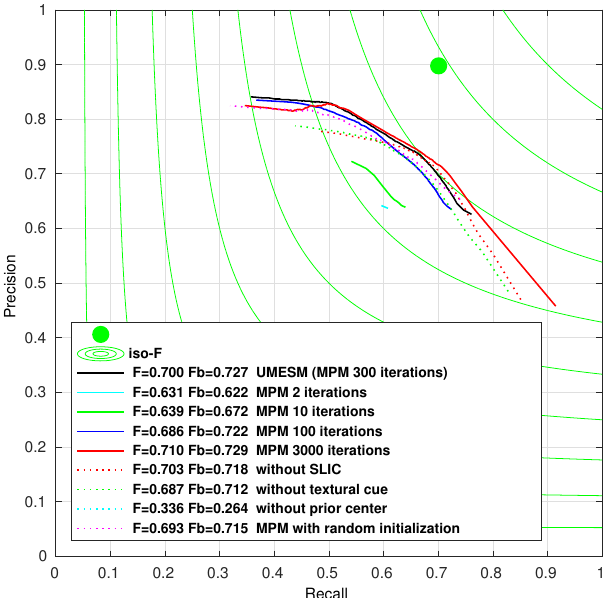
Figure 5. Precision–recall curves (and optimal F and F β -measures (see Equation (14))) for different variations of our UMESM (unsupervised Markovian estimation of saliency map) model on the ECSSD [68] dataset.